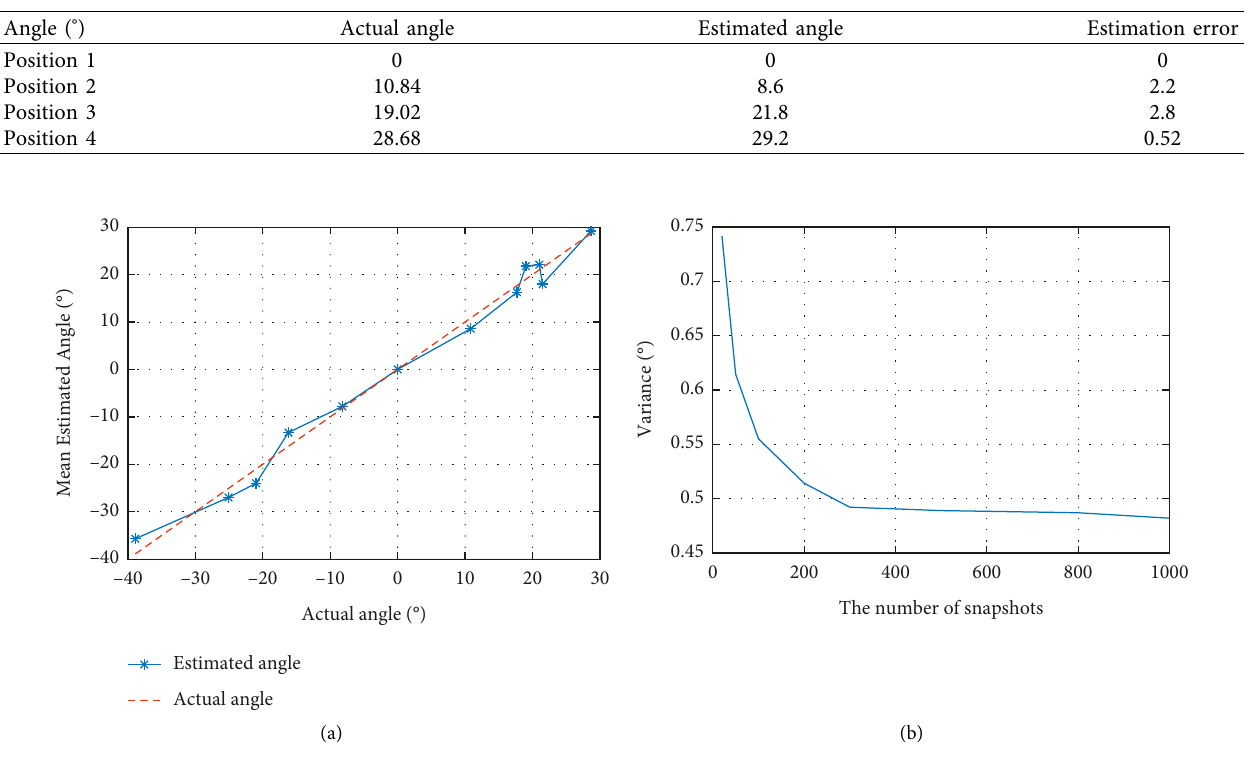
Figure 16: Experimental results (a, b).